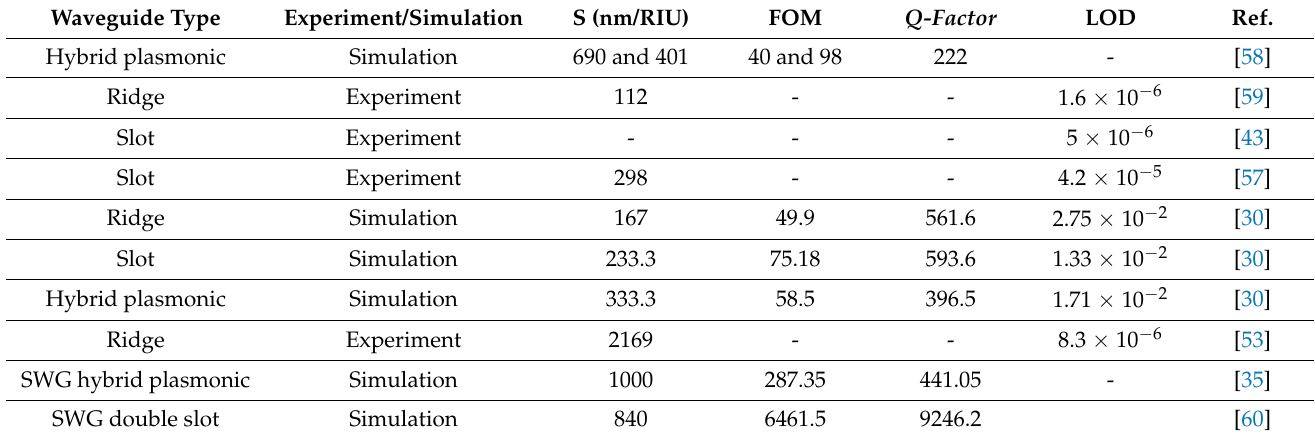
Table 1. Previously reported RR sensors and their sensing